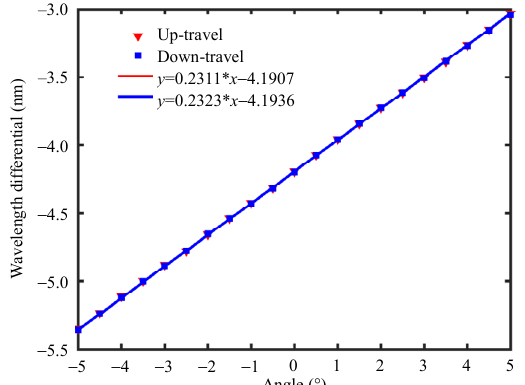
Fig. 11 Tilt sensitivity of the tilt sensor.